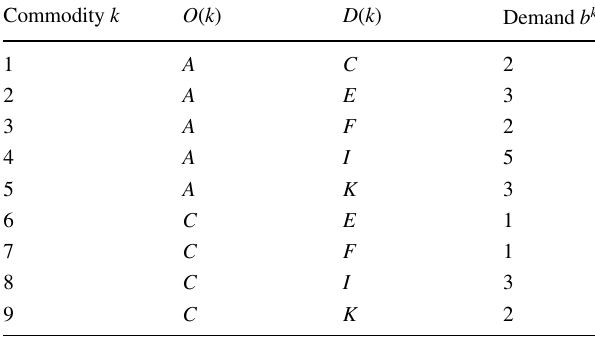
Table 8 The number of demands between origin and